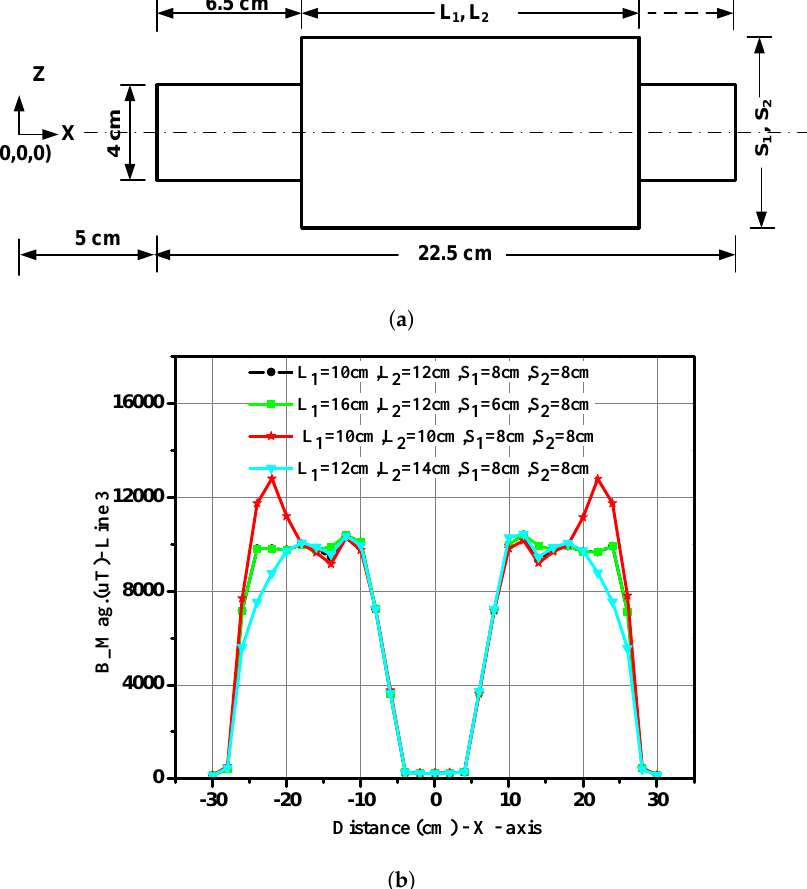
Figure 11. ( a ) Overview of one of the proposed optimum bars and ( b ) a part of the sweep results for different lengths and